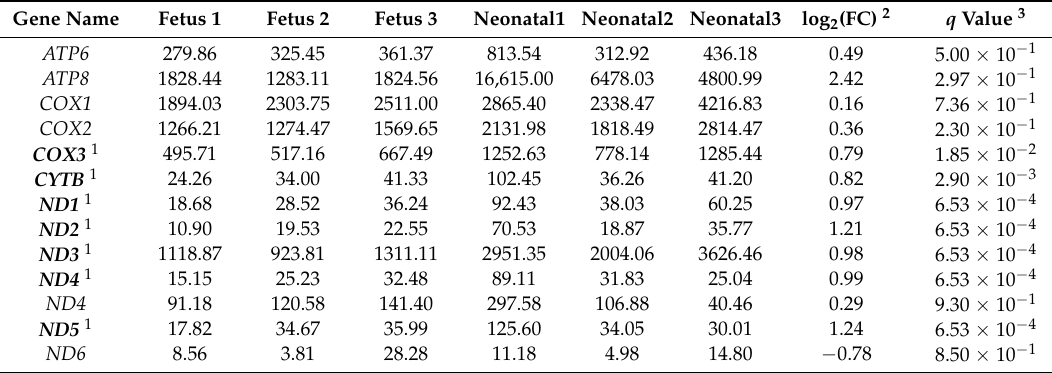
Table 2. Expression levels of annotated mitochondrial